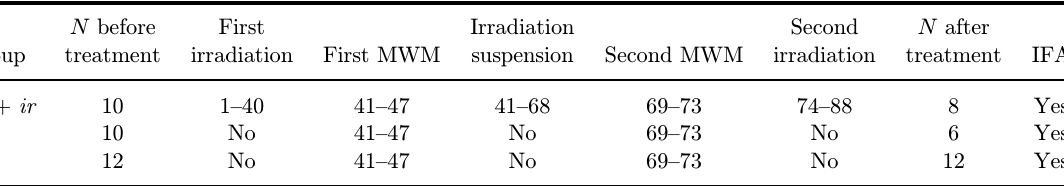
Table 1. The study paradigm of treatment and MWM experiments. The time arragement is shown from column 3 to column 7 and the unit was